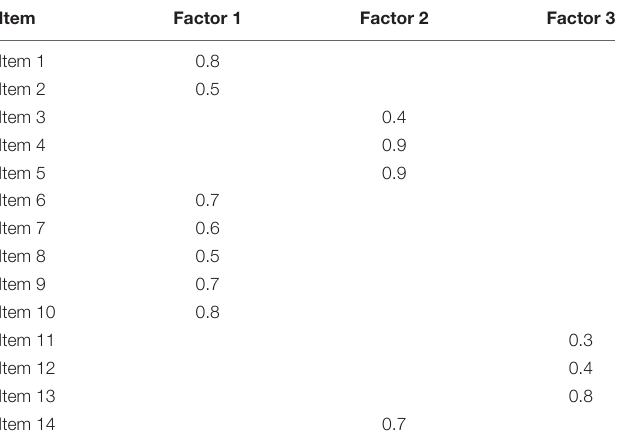
TABLE 5 | Rotated component matrix. Principal component analysis